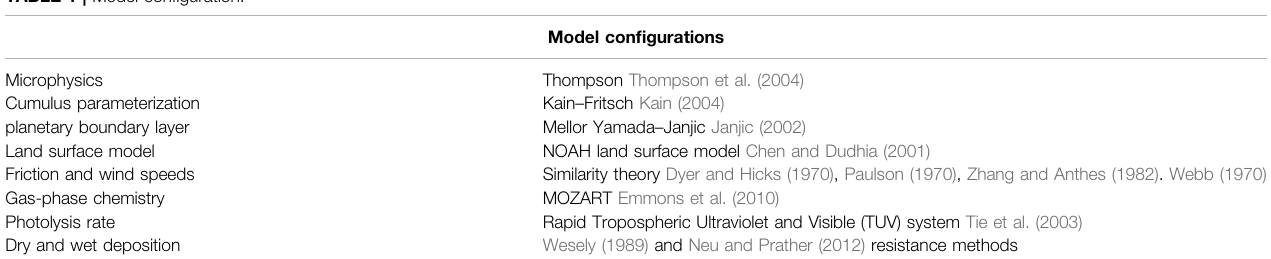
TABLE 1 | Model con fi